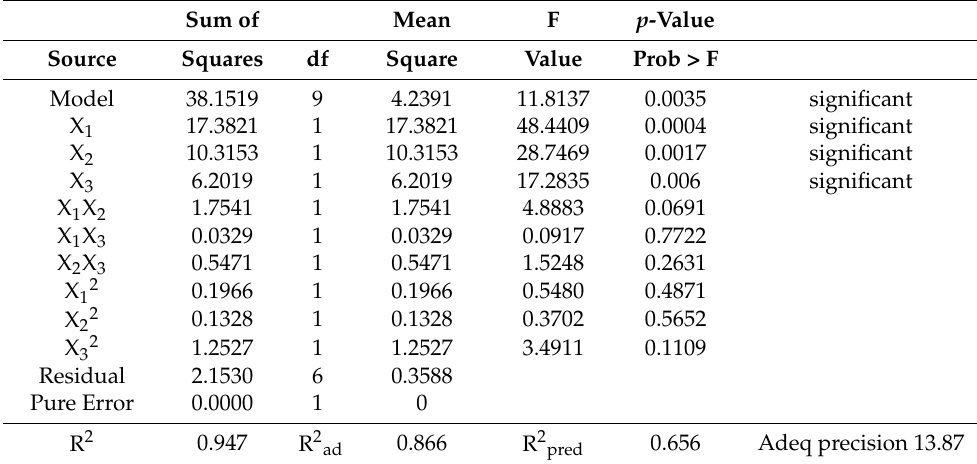
Table 5. ANOVA results for the response surface quadratic model on the FP process at 15 min.